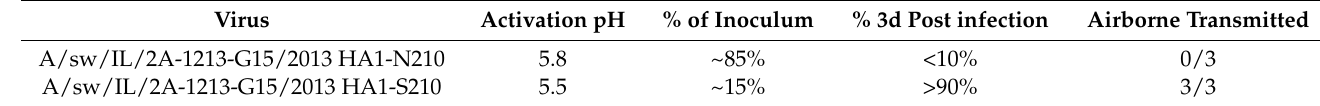
Table 7. A/swine/Illinois/2A-1213-G15/2013 (G15) HA stability variants in ferrets [176]. Virus Activation pH % of